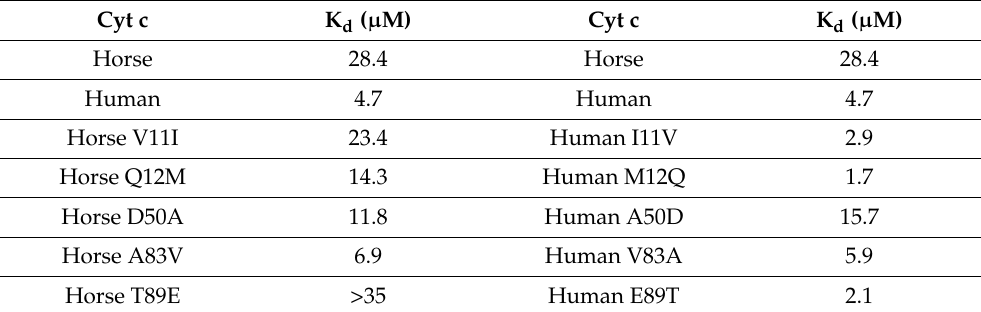
Table 1. Dissociation constants (K d ) of native or mutant Cc complex with bovine